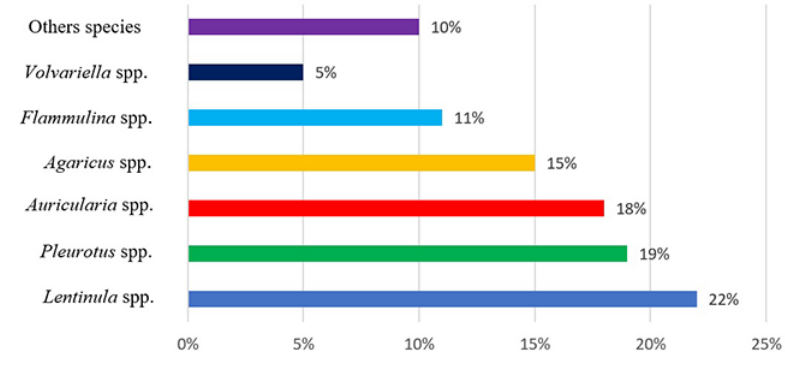
Figure 2 World edible mushroom production by genus in 2013 (Royse et al.,